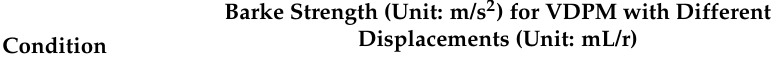
Table 3. Brake strength for VDPM.